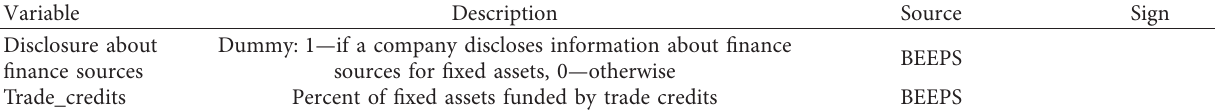
Table 1: Description of the model variables and expected direction of